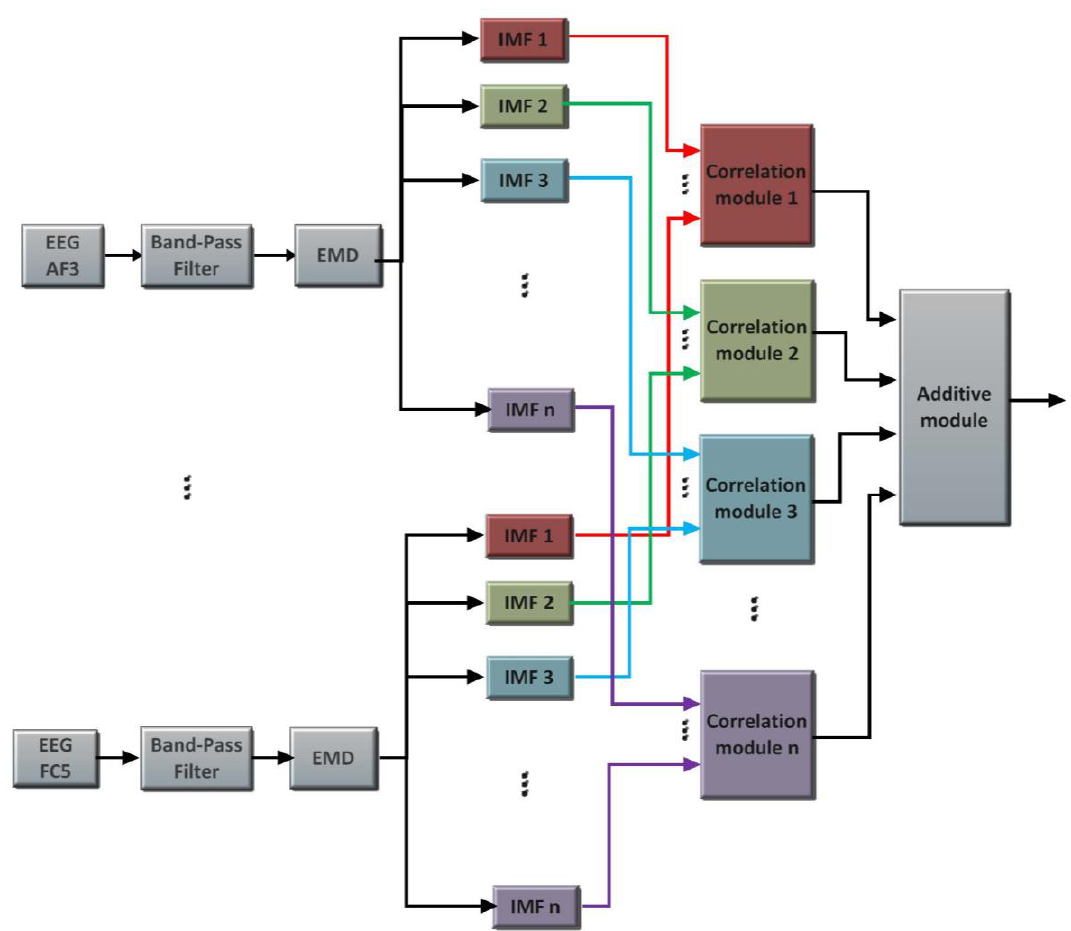
Figure 5. Preprocessing to reduce head movement